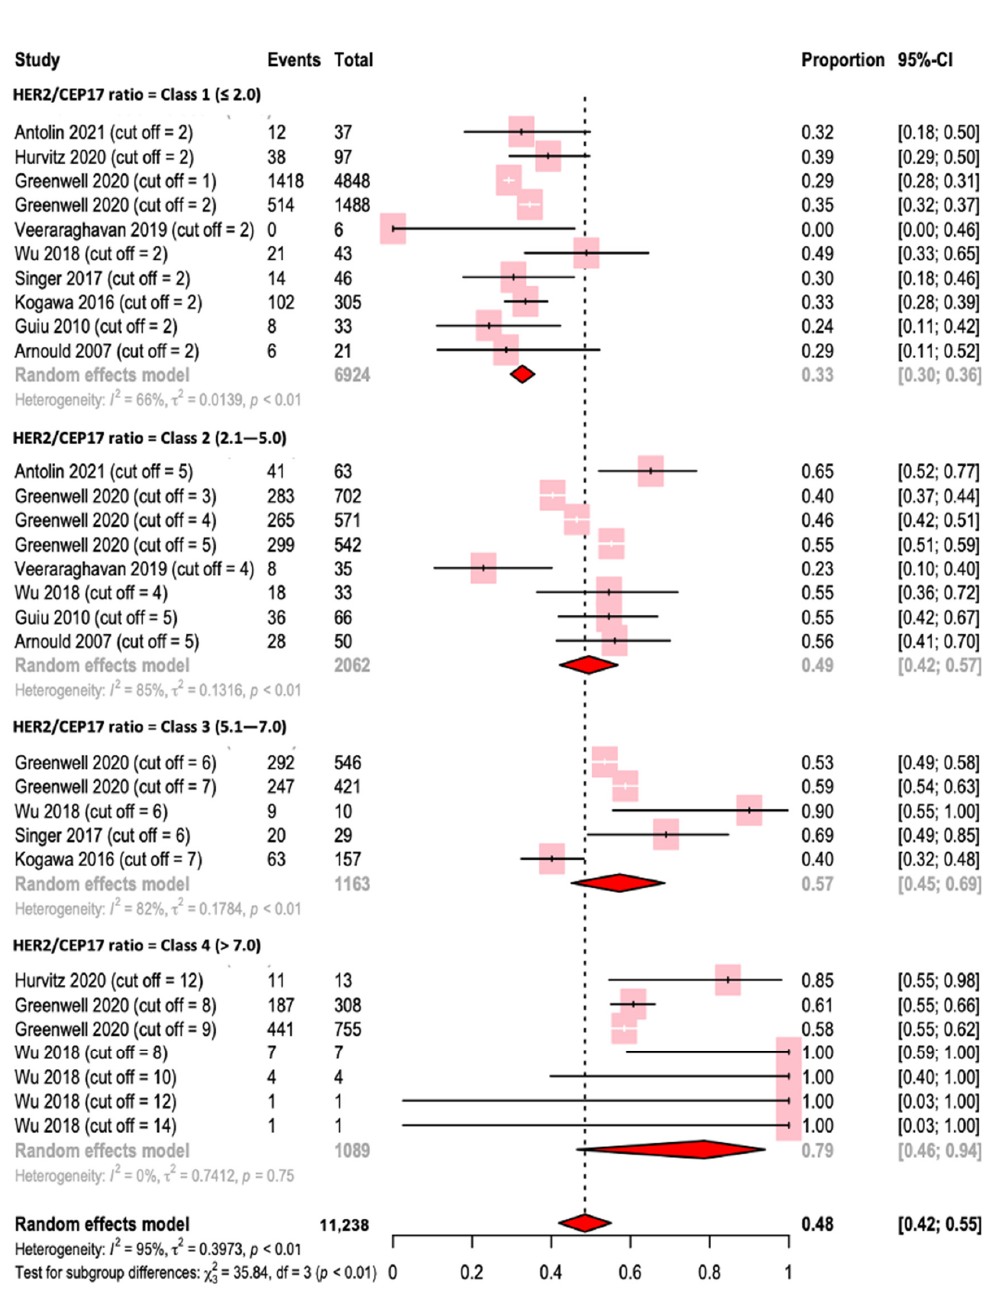
Figure 4. Forest plot for pathological complete response according to the HER2 interval (quartiles)